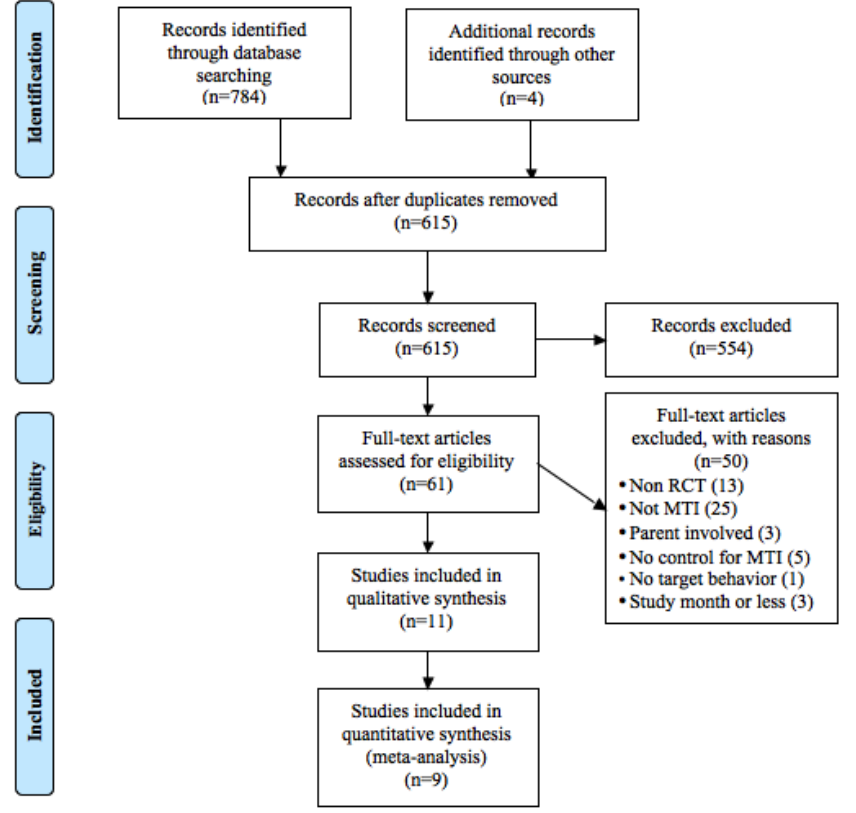
Figure 1. Flowchart of the study selection process for the systematic review and